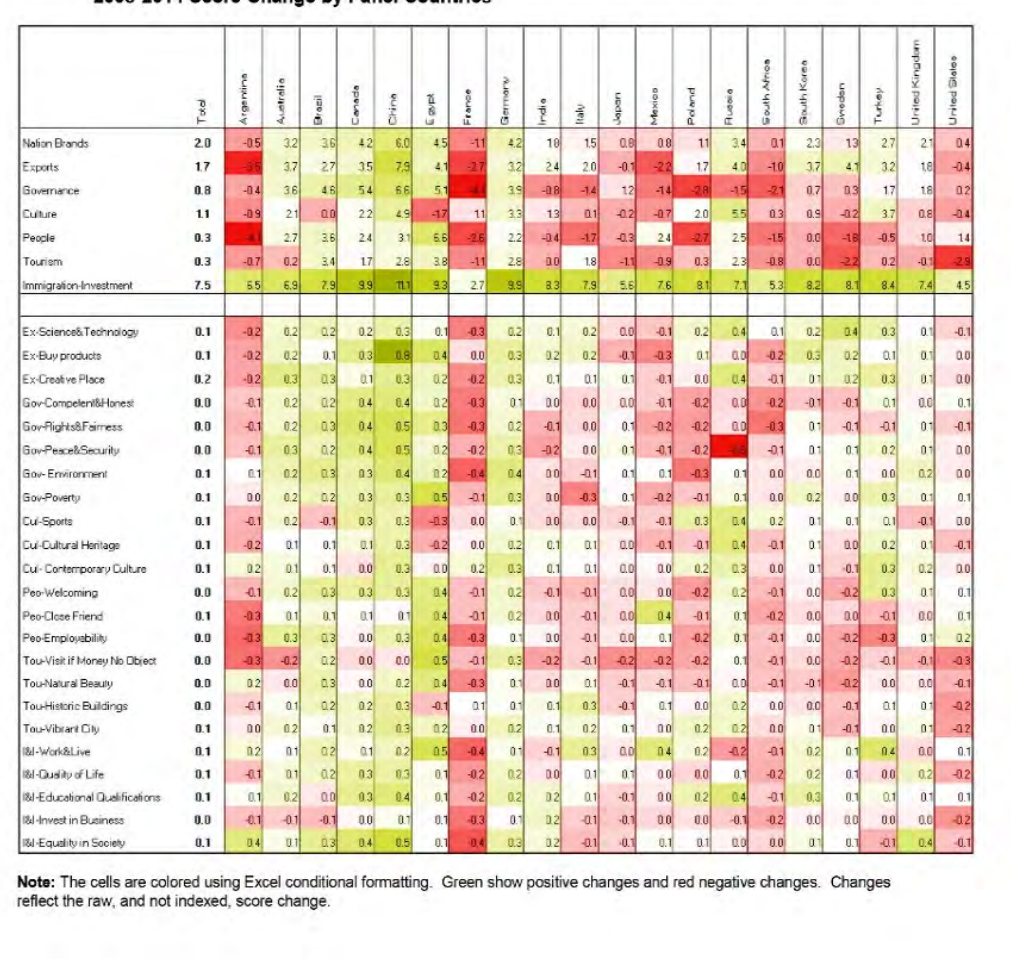
Figure 8. Egypt degrees around 50 country in 2008, 2014 GFK panel &